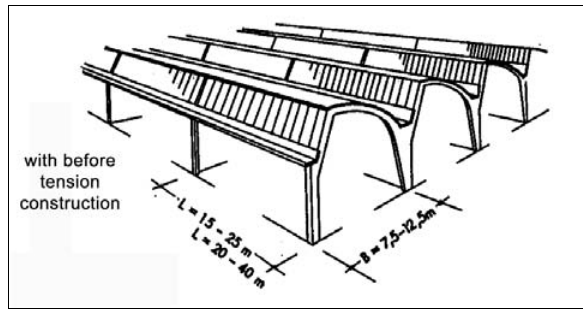
Fig 5. A saw-tooth roof with suitable window band, each unit is individually supported